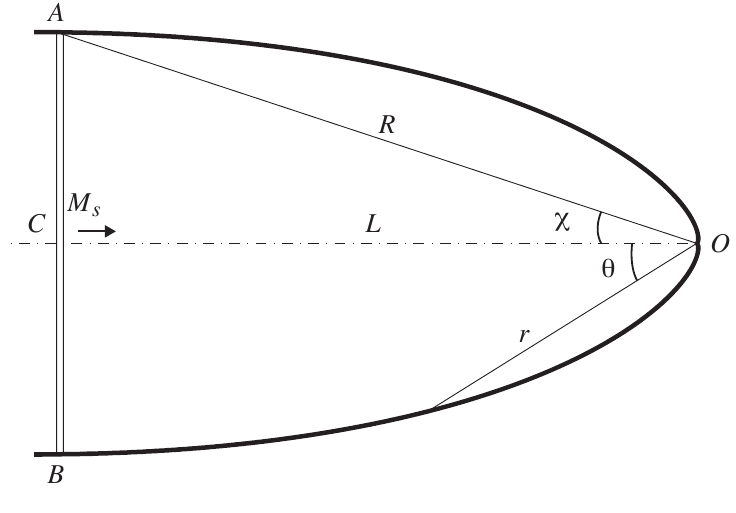
Figure 1. Logarithmic spiral for an M